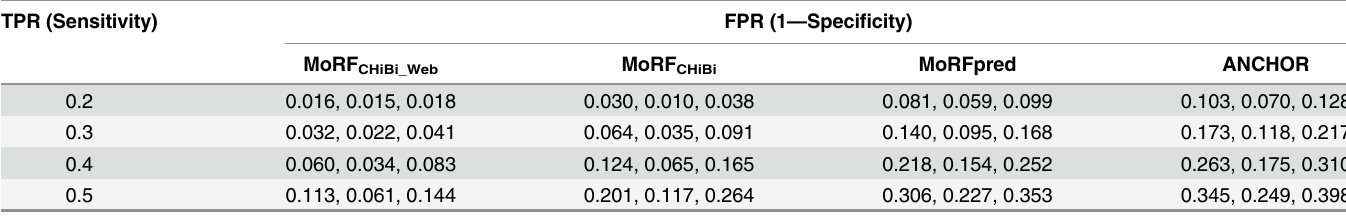
FPR as a function of TPR computed on the EXP53 set (All MoRFs , short MoRFs , long MoRFs) for MoRF CHiBi_Web , compared to MoRF CHiBi , MoRFpred , and ANCHOR at different TPR cut off values